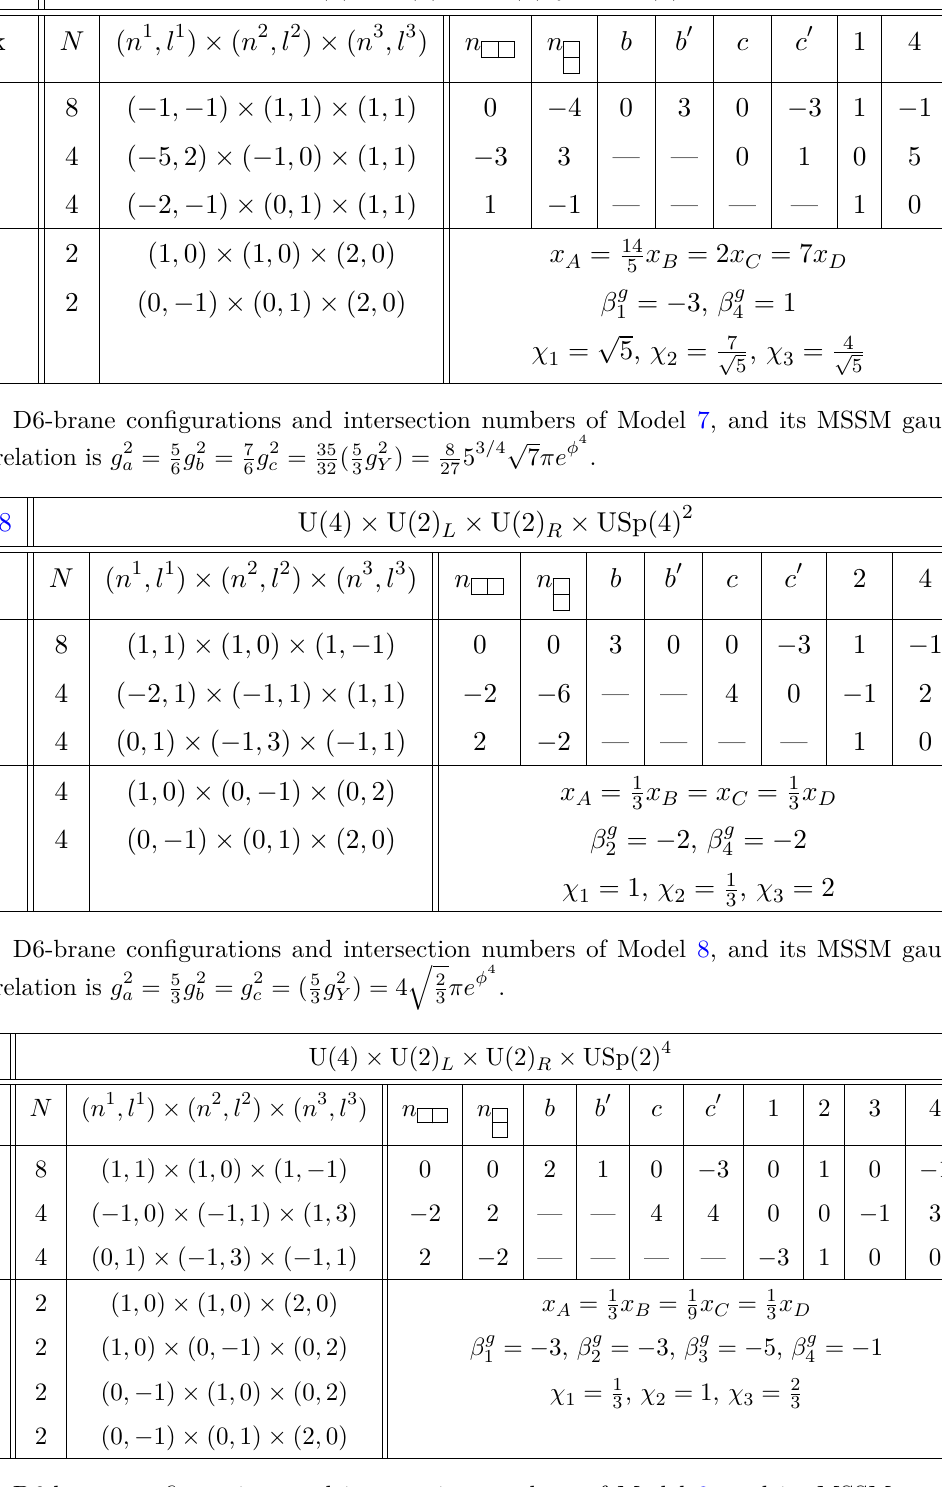
Table 9 . D6-brane configurations and intersection numbers of Model 9, and its MSSM